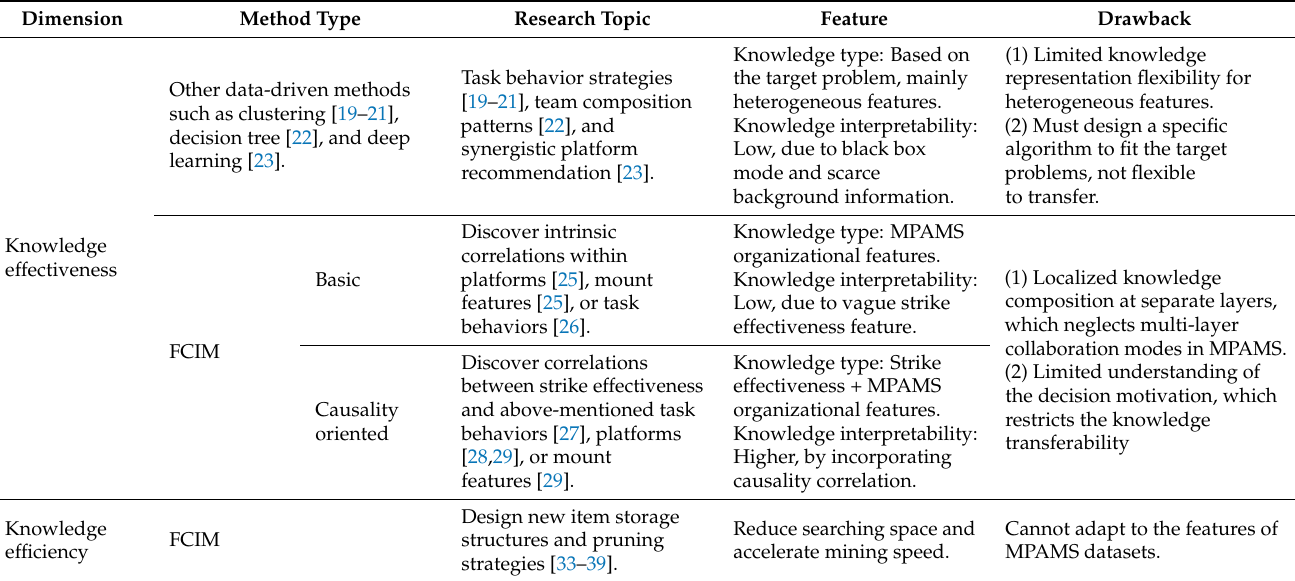
Table 1. Research status and gaps of knowledge mining effectiveness and efficiency issues.